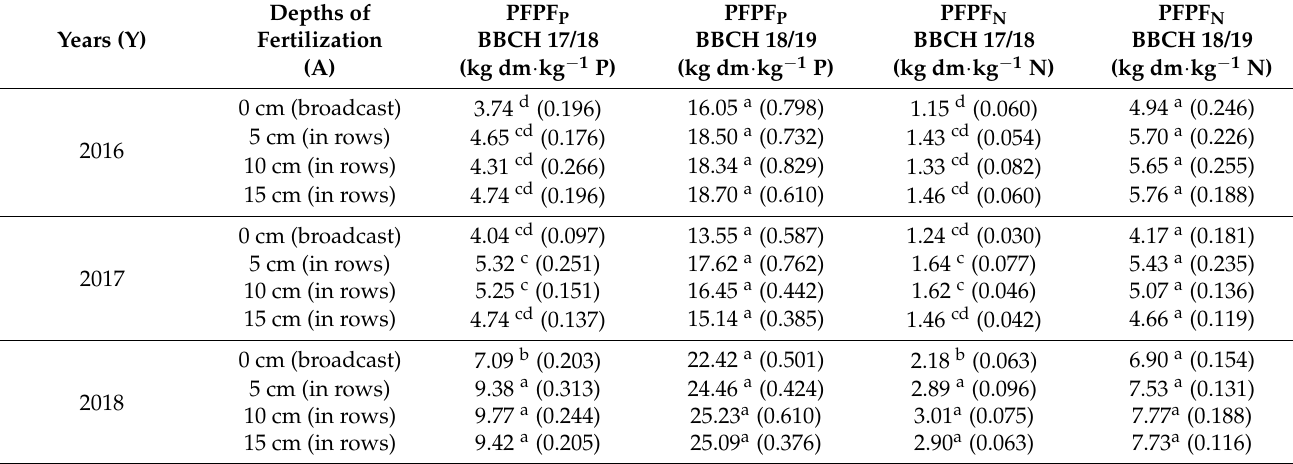
Table 9. Mean values for the combinations years (Y) × A factor and years (Y) × C factor. Depths Years (Y)